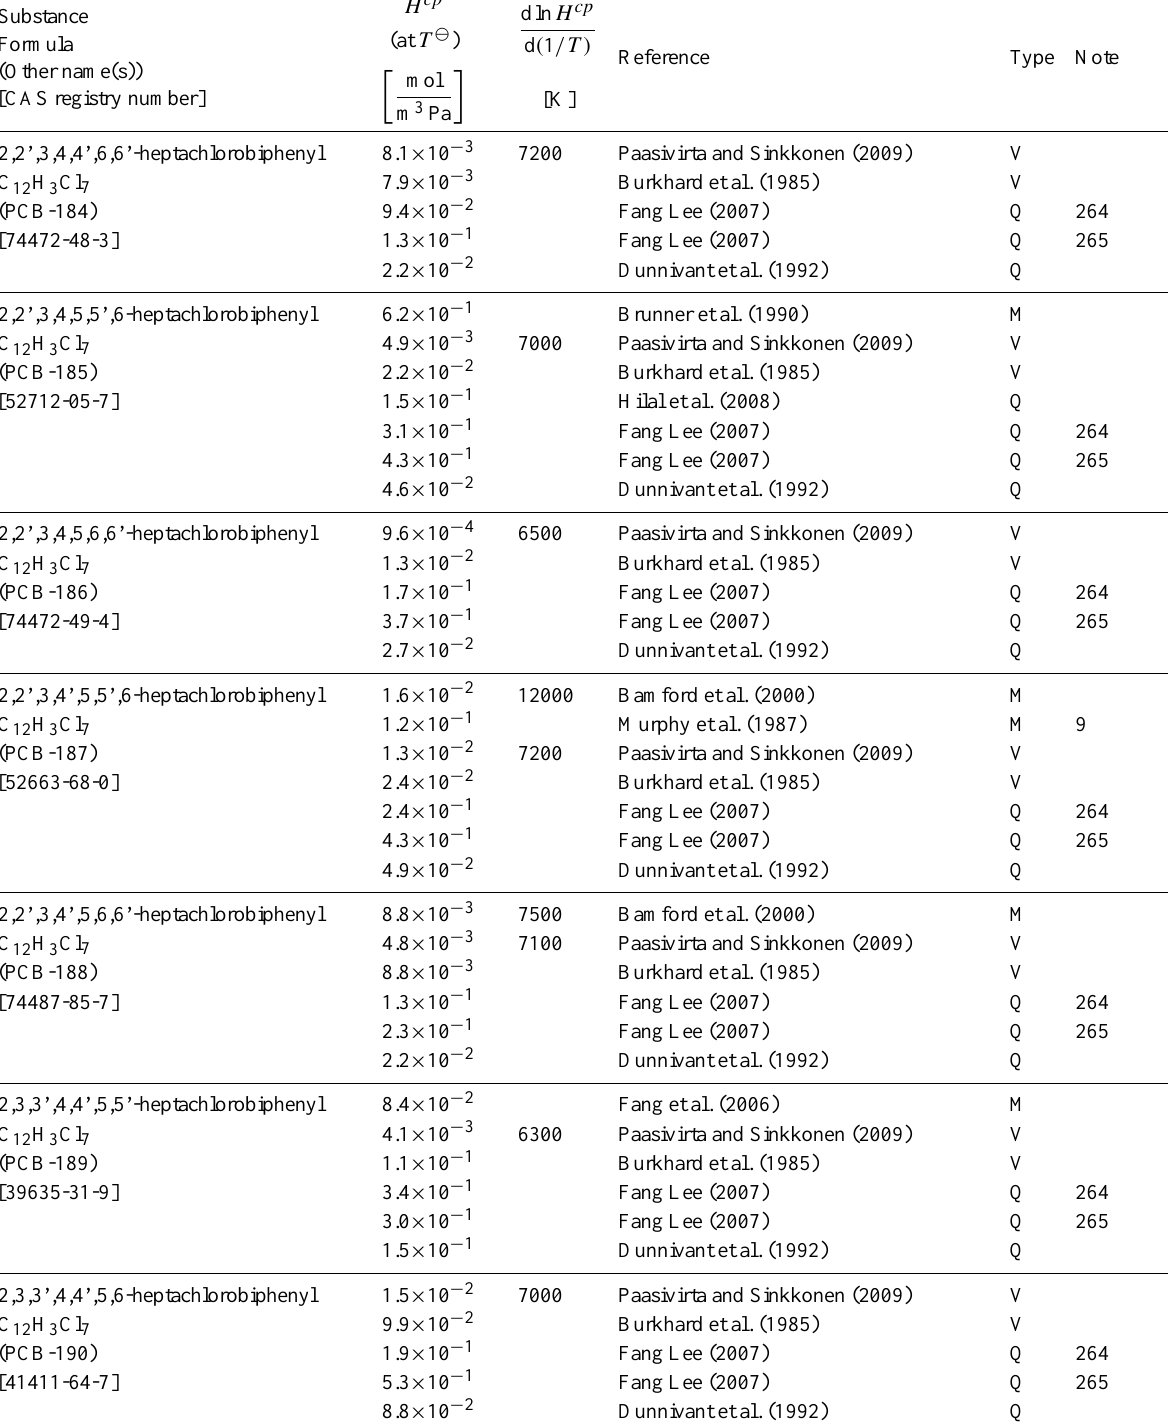
Table 6: Henry’s law constants for water as solvent